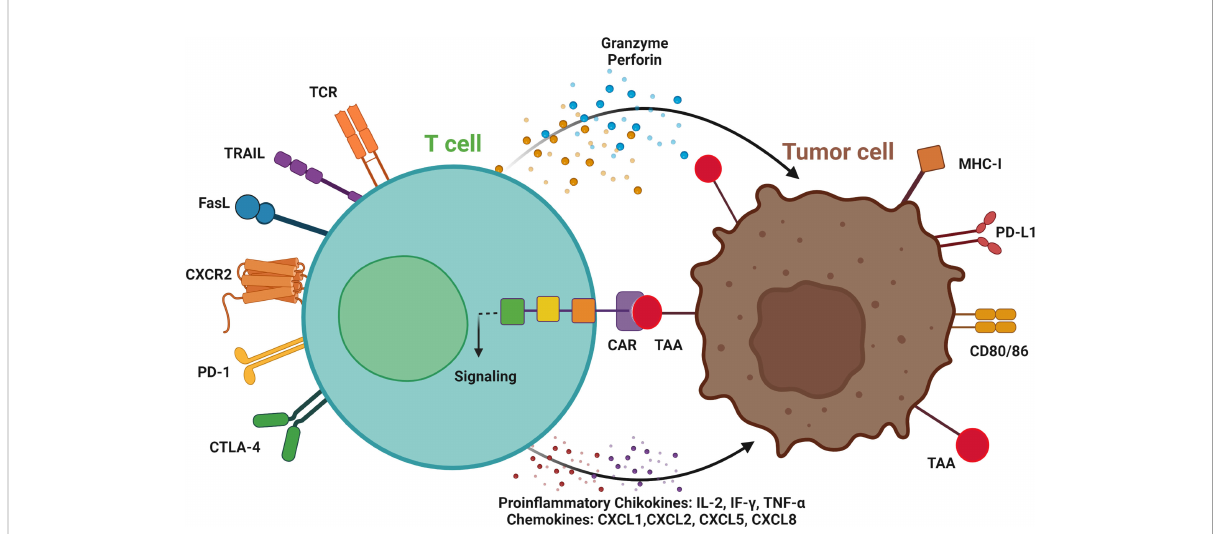
FIGURE 2 T cell-mediated antitumor effects by chimeric antigen receptors (CAR). Engineered CAR T-cells can recognize tumor cells by CAR binding to tumor-associated antigen (TAA), signaling activation and targeting the tumor cells by secreting granzymes, and perforins, and inducing TRAIL and FasL expression. CAR T-cells can be used as an ideal platform to deliver immune checkpoint therapeutic antibodies, such as anti-PD1 and CTLA-4 antibodies. CC-chemokine receptor 2; CD, cluster of differentiation; CTLA-4, cytotoxic T-lymphocyte associated protein 4; MHC, major histocompatibility complex; PD-1, programmed cell death protein-1; PD-L1, programmed death-ligand 1; and TCR, T cell receptor. Immune cells invade the tumor by activating proin fl ammatory cytokines and chemokines. Created with